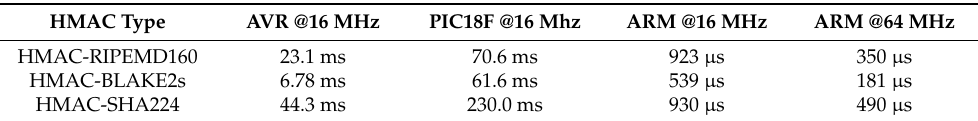
Table 4. Processing Times for the Considered HMAC Functions (less is